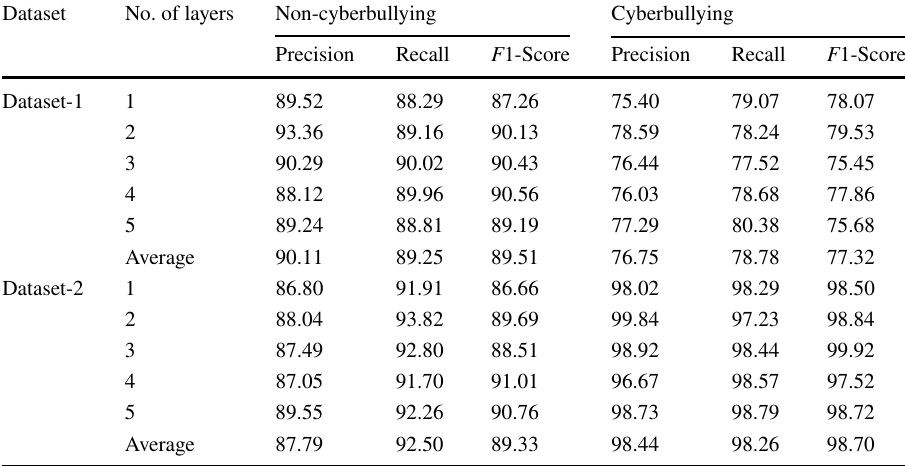
Table 1 Results analysis of proposed method in terms of each class